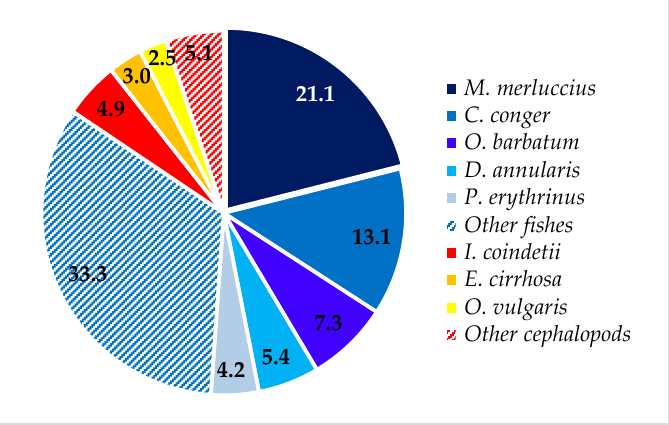
Figure 3. Numerical percentage of the main prey species found in T. truncatus stomachs. The European hake and conger eel were the most important species in both males (%IRI M. merluccius = 38.1; %IRI C. conger = 23.9) and females (%IRI M. merluccius = 18.35; %IRI C. conger = 23.7). Other significant fish families in the diet of males were Sparidae (%IRI = 11.4) and Mugilidae (%IRI = 8.6). Sparids were also very important in the diet of females (%IRI = 22.5) and in the number of predated species. As a matter of fact, there were nine species of sparids found in females and only four in males. Other fishes